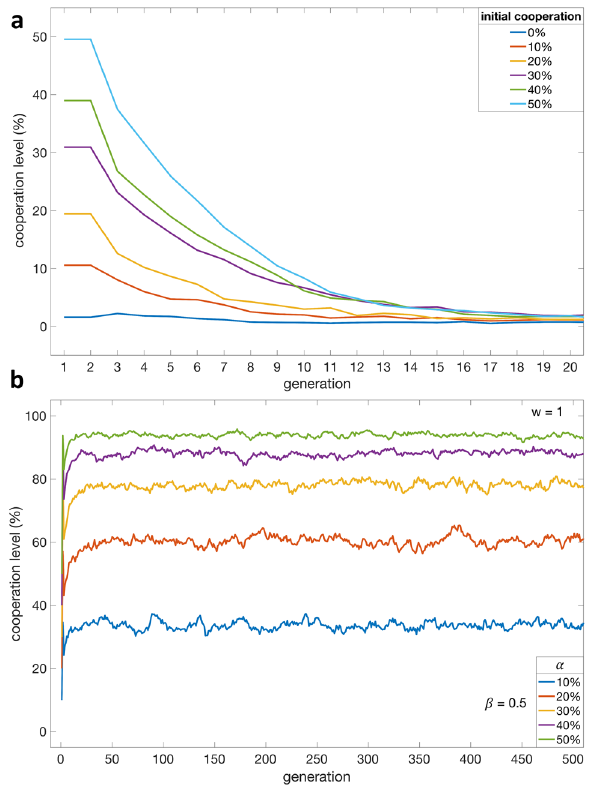
Figure 1. The evolution of conditional cooperation. The x-axis represents the generation, the y-axis represents the cooperation level, and each color-coded trajectory depicts the evolutionary dynamics of cooperation under different experimental conditions, given β = 0.5 . a , Evolution of cooperation in the absence of altruists, given different percentages of cooperation decisions made in the first generation. b , Evolution of cooperation given different percentages of altruists present across generations when w = 1